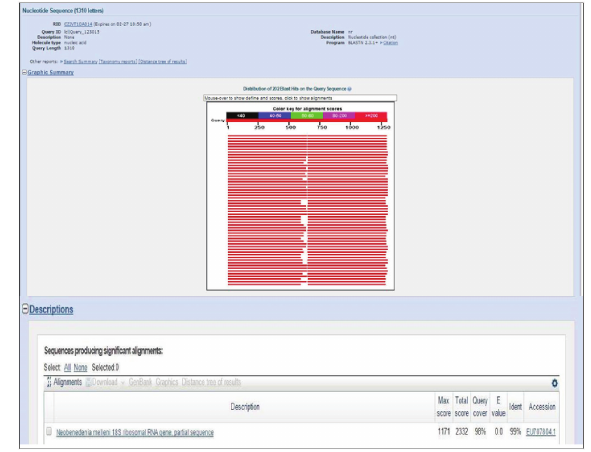
Figure 8: Nucleotide BLAST sequence for PCR product.